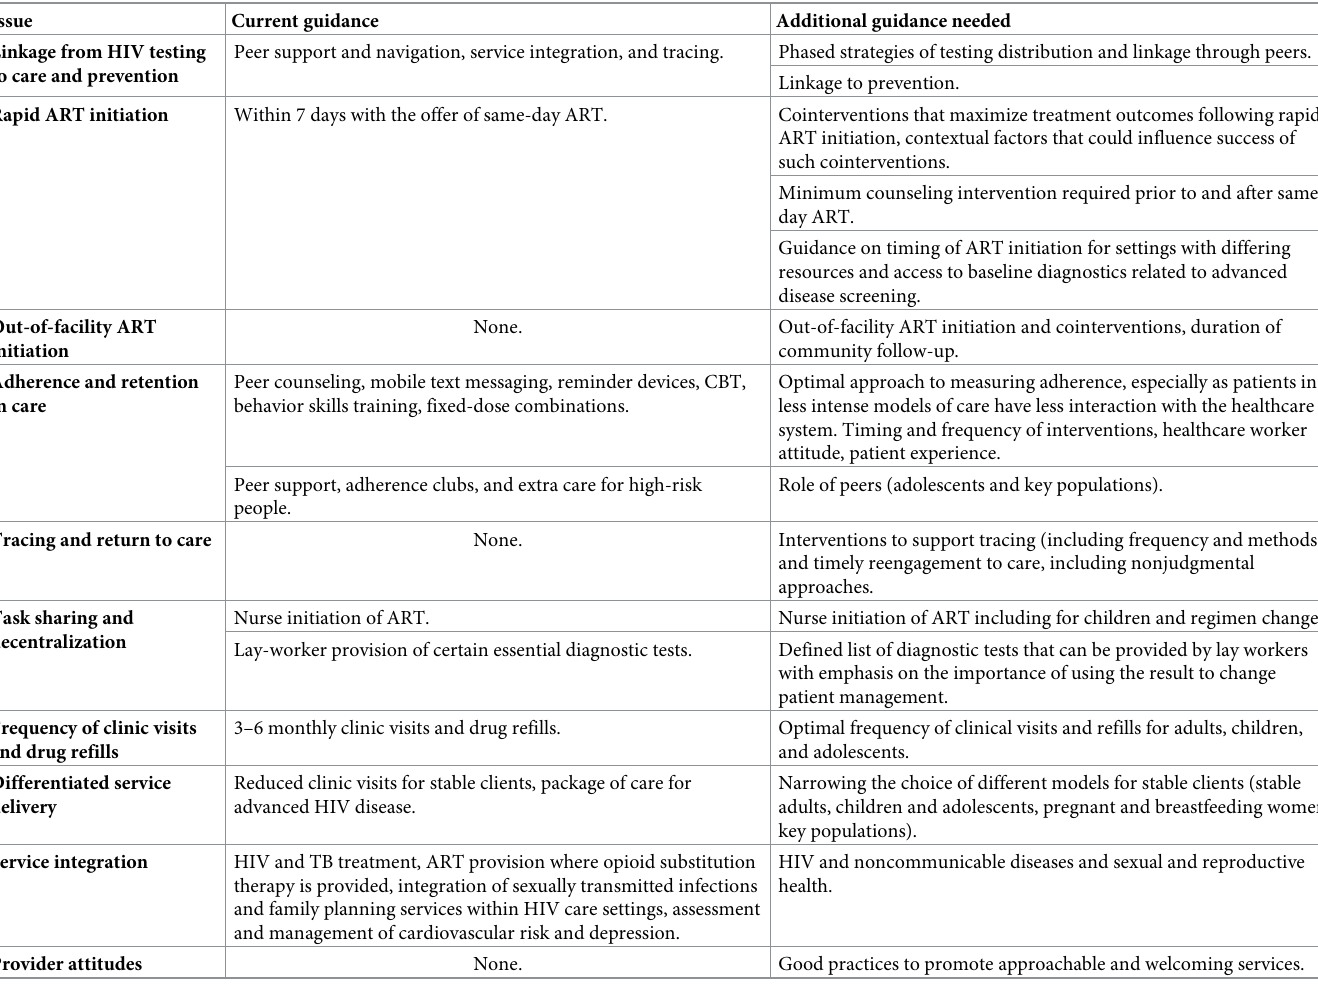
Table 1. Evolution of HIV service delivery